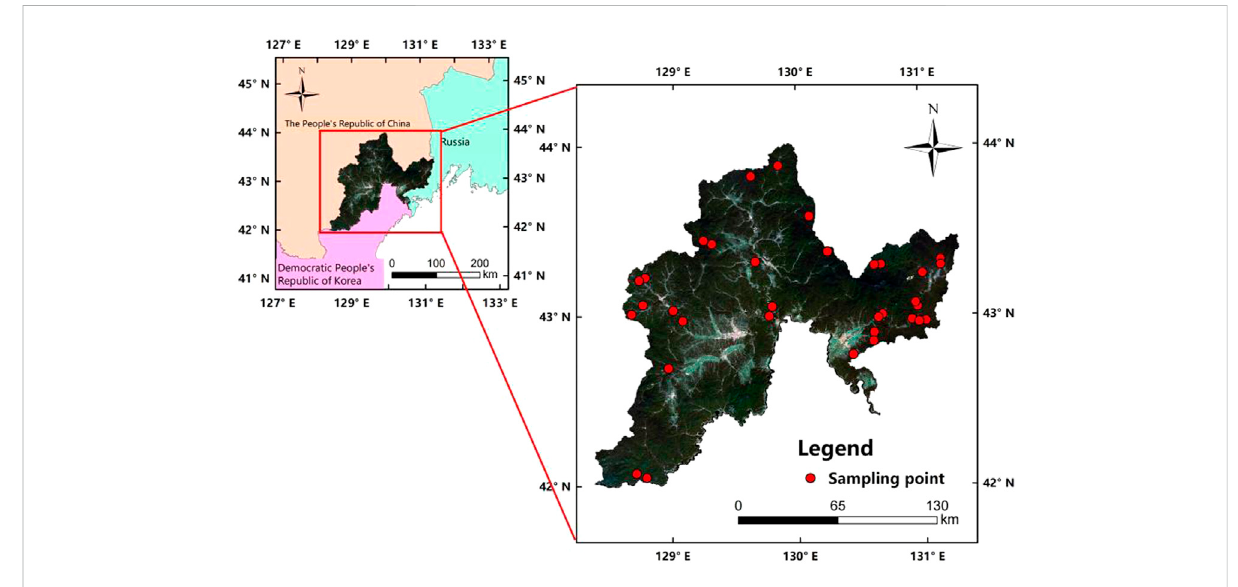
FIGURE 1 Study area and distribution points of Deyeuxia angustifolia .